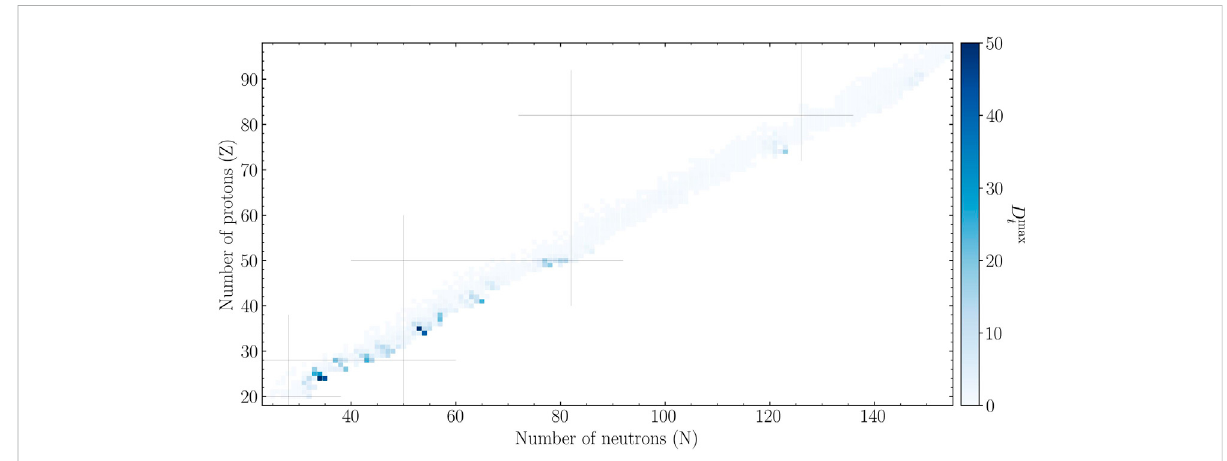
FIGURE 6 Nuclear heating rate sensitivity across thenuclear chart. Foreach nucleus, theshading represents the maximum sensitivitymeasure D t attained at any time t = 0.1, 1, 10, 100 days.